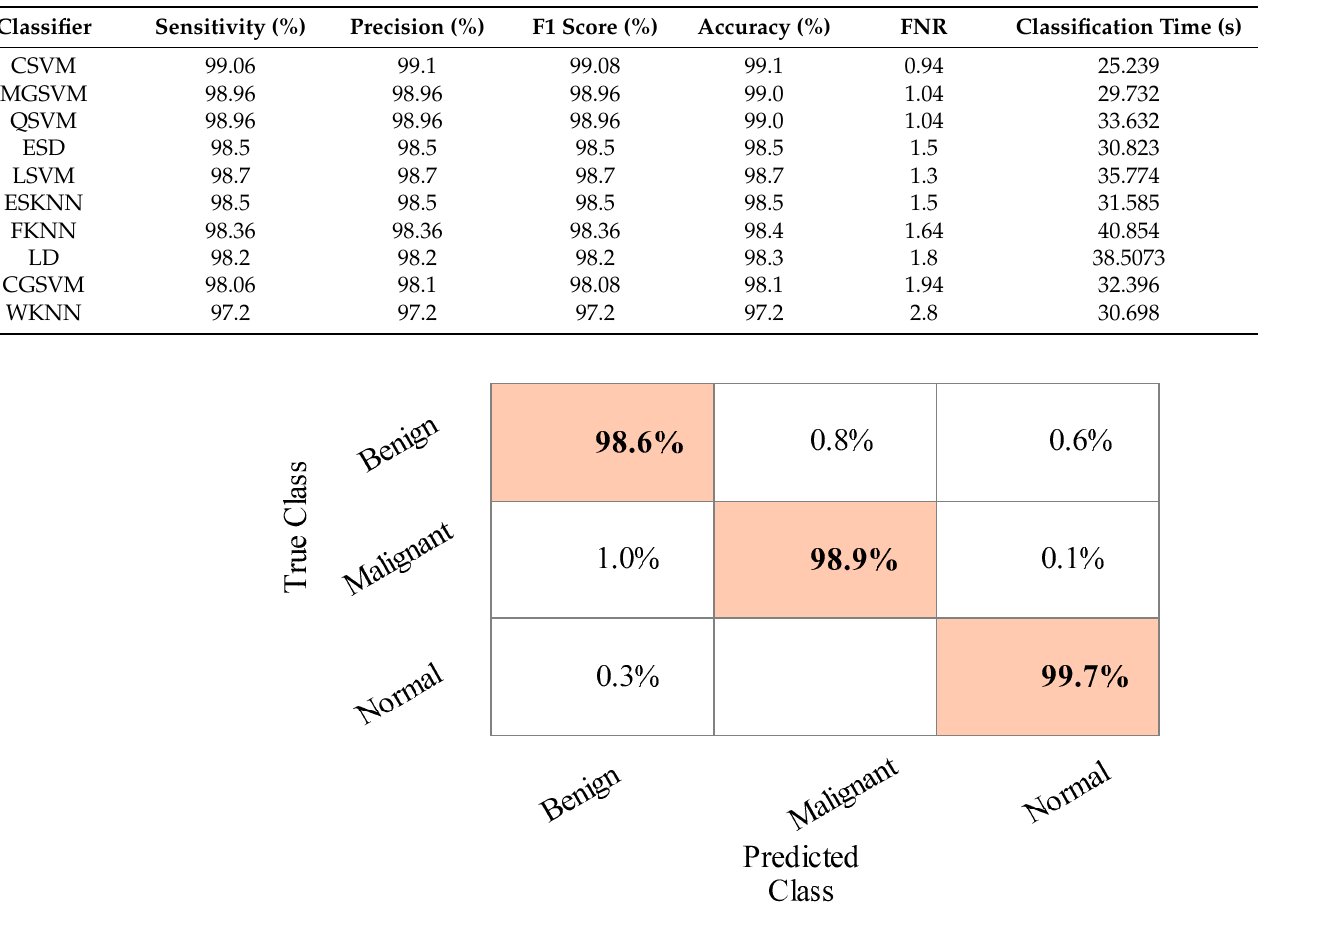
Figure 11. Confusion matrix of Cubic SVM for BGWO-based best feature selection.